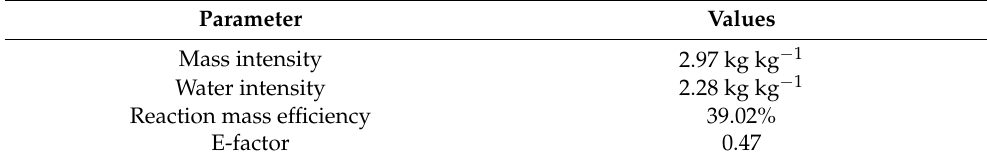
Figure 10. CO 2 adsorption–desorption curve of CCA at room temperature. Table 3. Sustainability parameters.